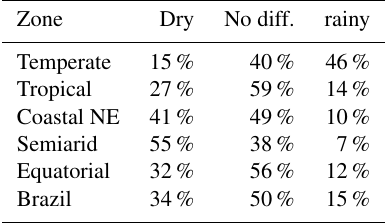
Table 3. Frequency of higher minimum temperature during dry and rainy days.